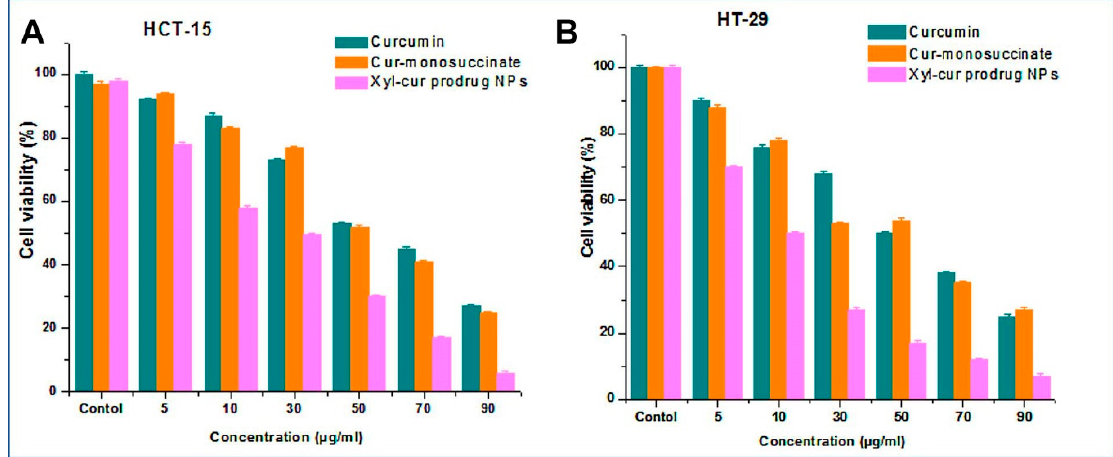
Figure 4. Cytotoxicity of free curcumin, functionalized curcumin, and curcumin prodrug XNPs against colon cancer cells, i.e., ( A ) HCT-15 and ( B ) HT-29 (Reprinted with permission from ref [34]. Copyright © 2018 Elsevier).